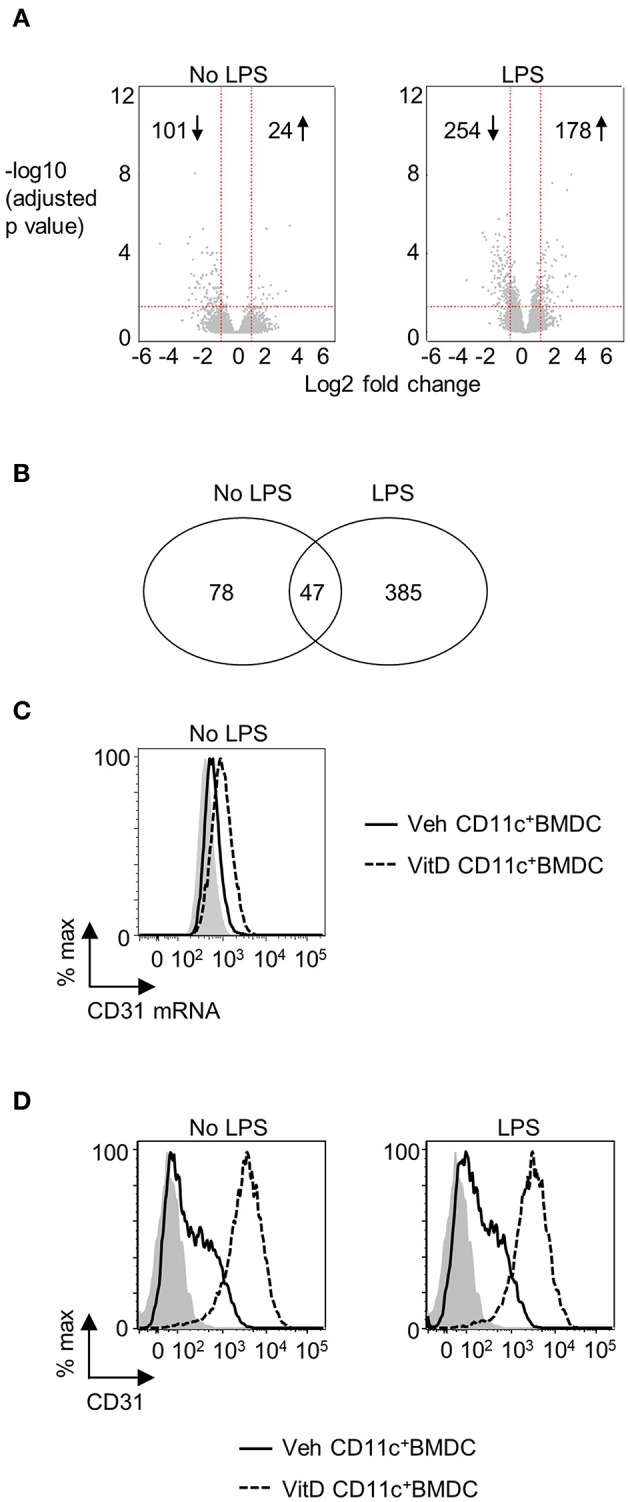
CD31 is upregulated by 1,25(OH)2D3 in BMDC. Bone marrow derived dendritic cells (BMDC) were generated over 9 days in the presence of 1,25(OH)2D3 (VitD) or absence (Veh) of 20 mM 1,25(OH)2D3. (A) Veh and VitD BMDC were matured for 18 h in the presence or absence of 0.1 μg/ml LPS. mRNA was extracted and microarray performed. Differential gene expression caused by 1,25(OH)2D3 in the absence (left) or presence of LPS stimulation (right) is depicted as volcano plots. (B) Number of genes differentially regulated by 1,25(OH)2D3 in CD11c+BMDC in the presence or absence of LPS stimulation. (C) Representative flow plot of CD31 mRNA levels in Veh (continuous line) and VitD (dashed line) CD11c+BMDC as assessed by PrimeFlow. Fluorescence minus one is indicated by gray shaded area. n = 3. (D) Representative flow plots of CD31 protein expression in Veh (continuous line) and VitD (dashed line) CD11c+BMDC in the absence (left panel) or presence (right panel) of LPS stimulation as assessed by flow cytometry. Isotype control is indicated by gray shaded area.